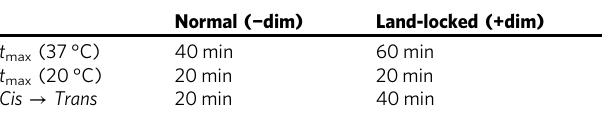
Table 3 Summary quanti fi cation of bulk secretion and processing through normal or land-locked Golgi cells Normal ( −